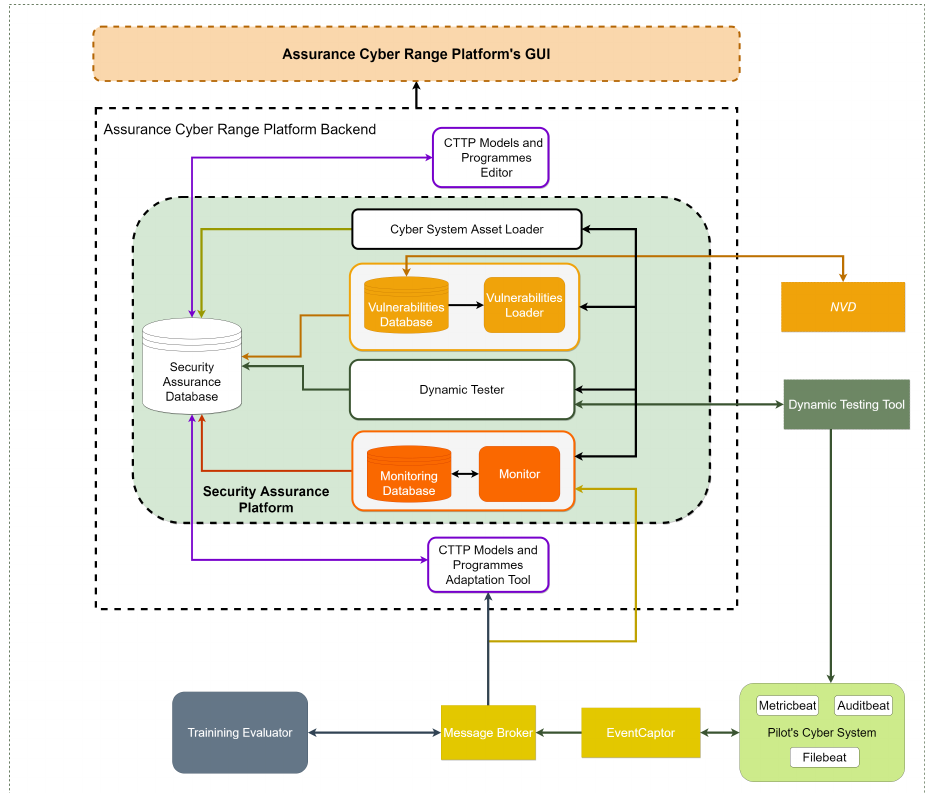
Figure 2. CYRA’s